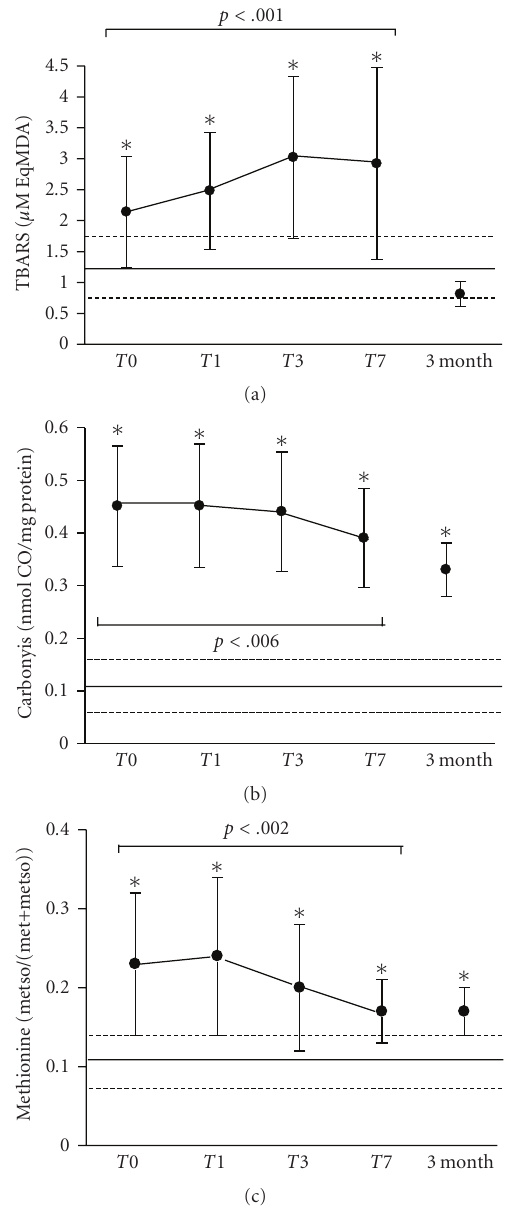
Figure 1: Temporal evolution of oxidative damage of all septic shock patients in (a) lipoperoxidation (TBARS), (b) carbonyls, and (c) Methionine sulfoxide. Normal values (mean ± SD) obtained from matched healthy subjects are shown as continuous and dotted lines, respectively. p : reflects variation in time calculated by linear mixed e ff ects model. ∗ Indicates significant di ff erences between normal values and patients at di ff erent time points ( t -test for independent samples).